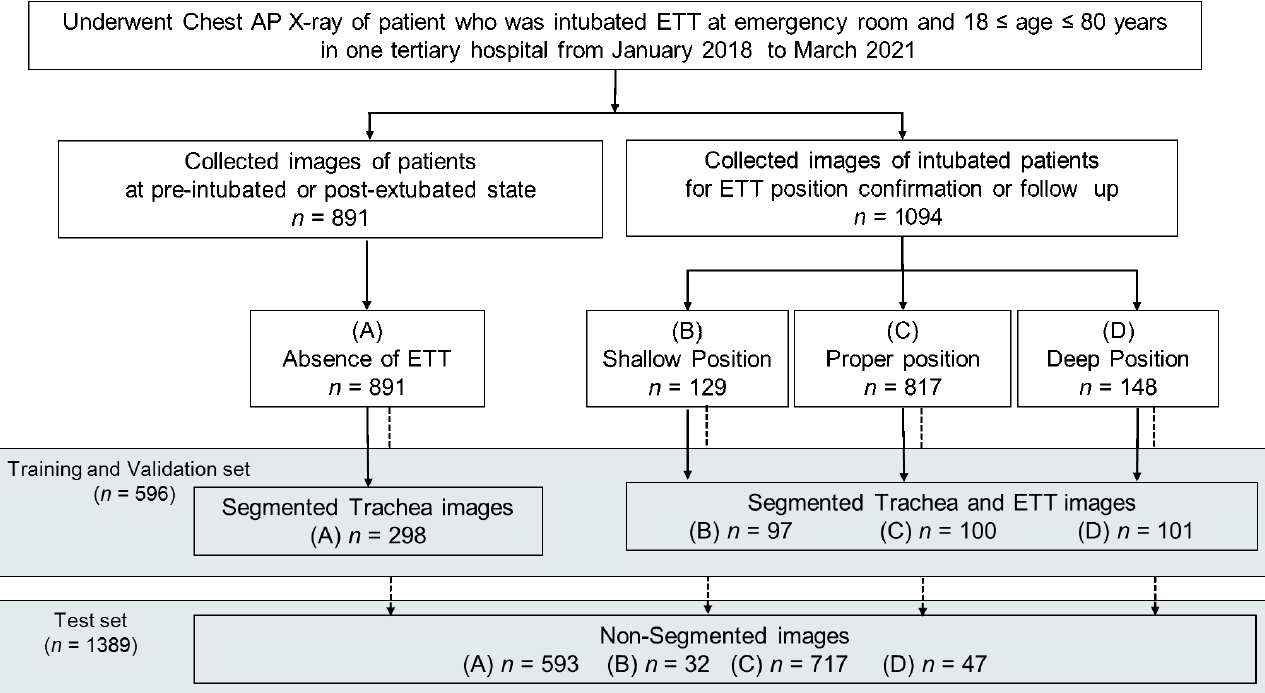
Figure 1. Flowchart of data collection for training/validation with segmented images and a test set with non-segmented images in the